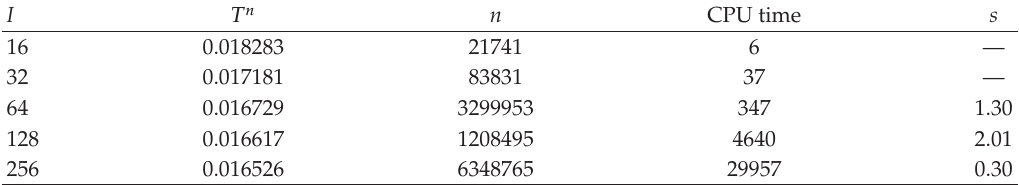
Table 4: Numerical blow-up times, numbers of iterations, CPU times (cid:3) seconds (cid:4) and orders of the approximations obtained with the implicit Euler method defined in (cid:3) 10.2 (cid:4) .